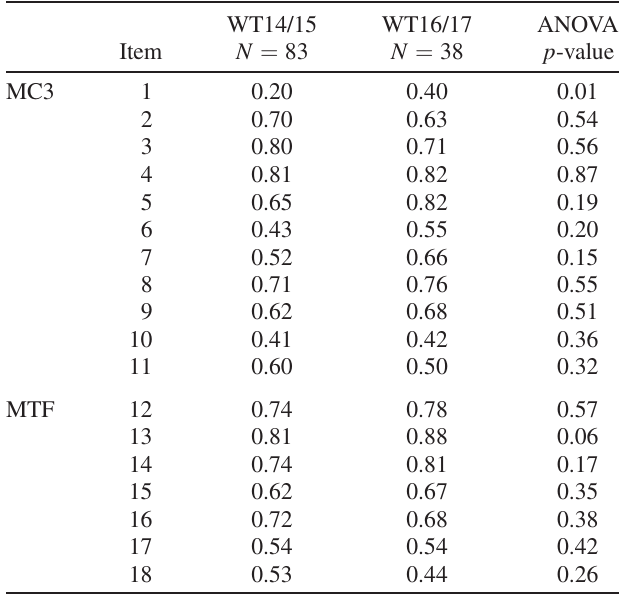
TABLE VII. KiRC item difficulties obtained in both samples. ANOVA p values indicate chance levels for differences found between the two